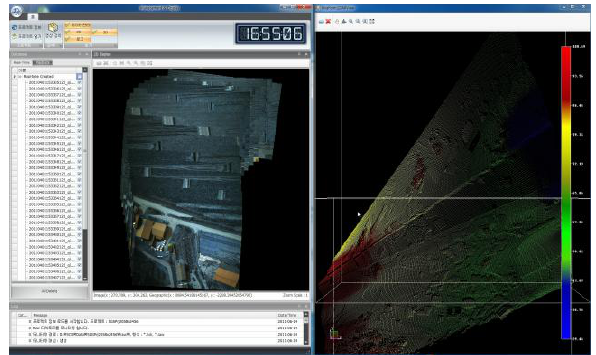
Figure 9. Real-time display subsystem